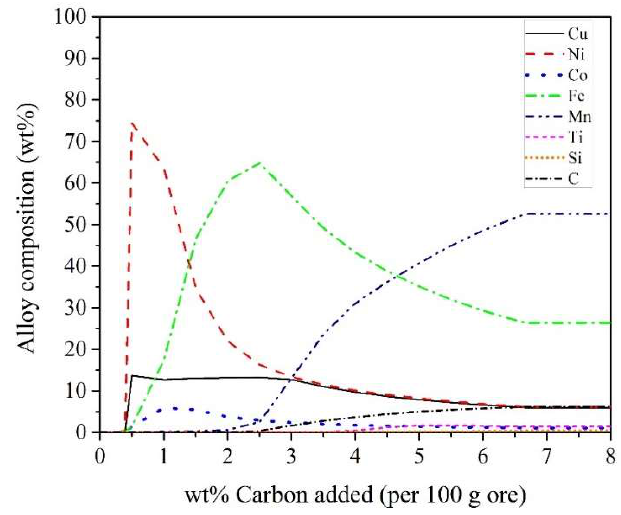
Figure 4. Reduction degree and alloy composition as a function of carbon addition for 100 g ore and 10 g SiO 2 at 1350 °C.